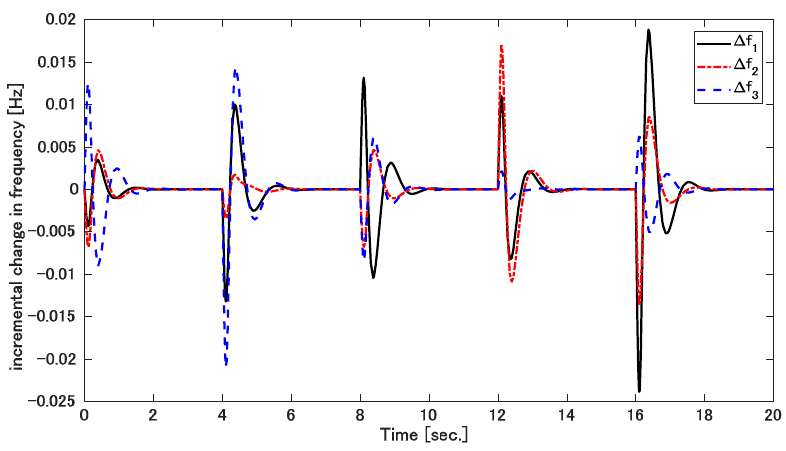
Figure 19. Frequency deviation without wind plant.